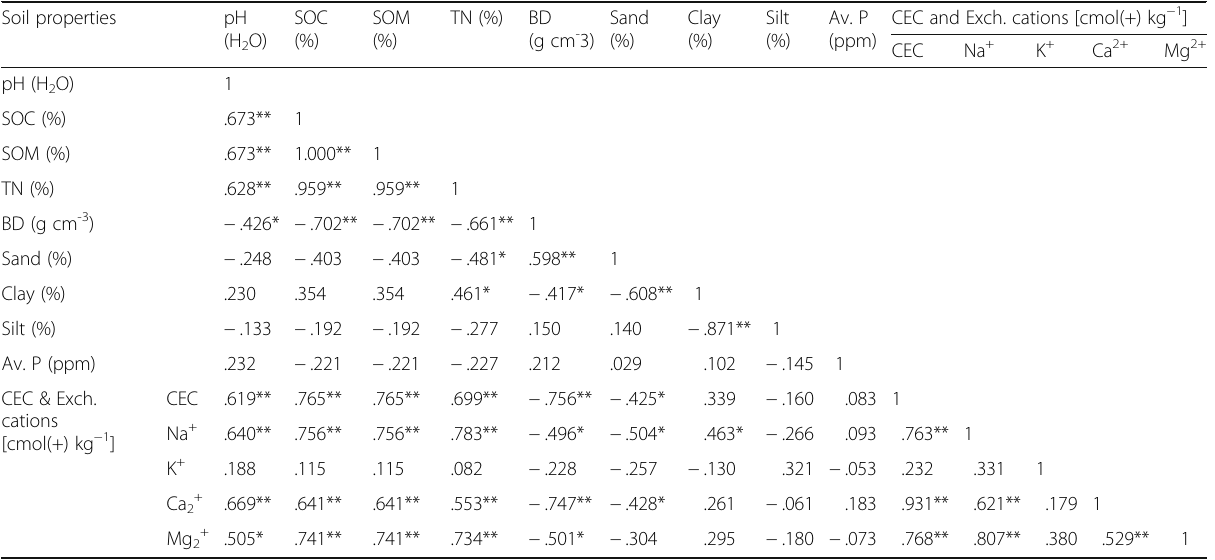
Table 7 The relationship (Pearson ’ s product movement coefficient of correlation) between soil physicochemical properties Soil